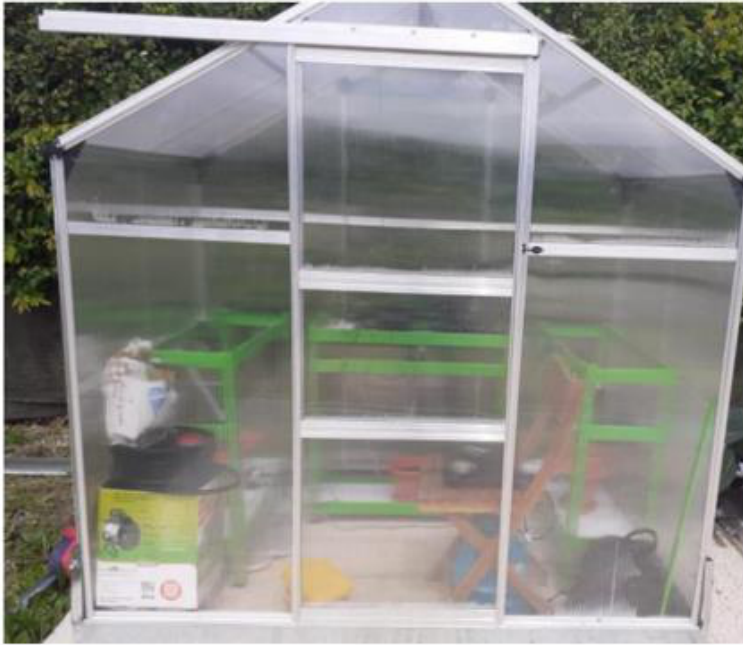
Figure 1. Experimental greenhouse. Although the indoor data that was used for the validation was from this greenhouse system, the exogenous data were obtained from the Cranfield weather station as shown in Figure 2.